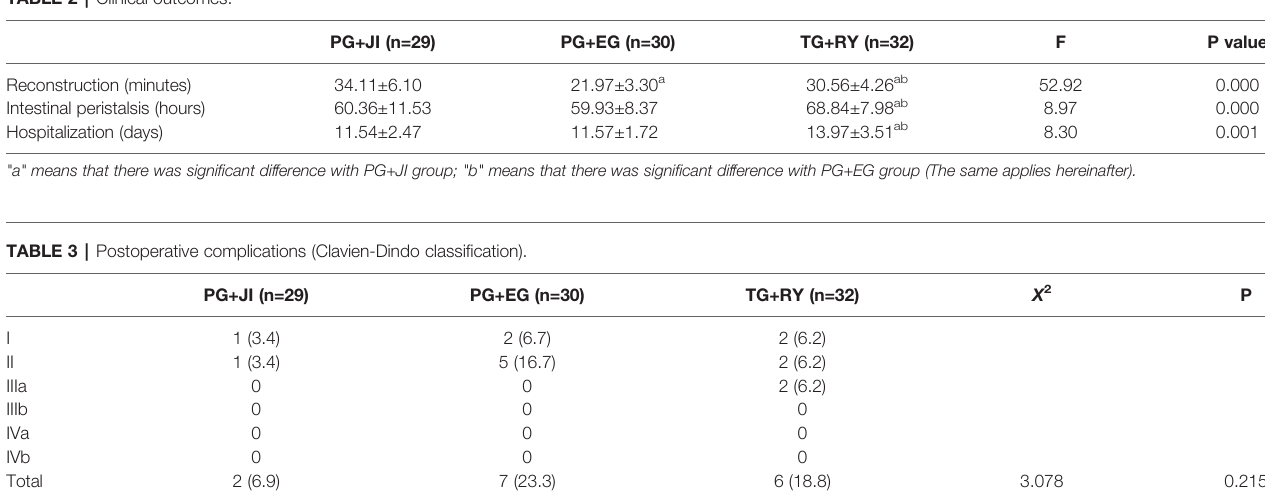
( Table 4 ). LA classi fi cation and GSRS score: The percentages of scores over A or 1 were higher in the PG+EG and TG+RY groups than that in the PG+JI group